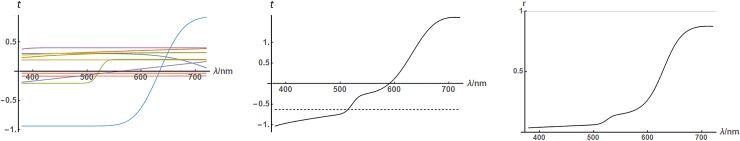
Shows computation of a sigmoid-sum reflectance.In this example, the random number of sigmoid components (left) was 10. These are summed and normalized to zero-mean (middle, solid) then added to a random DC component (middle, dotted). The sum is then transformed to the reflectance domain (right).